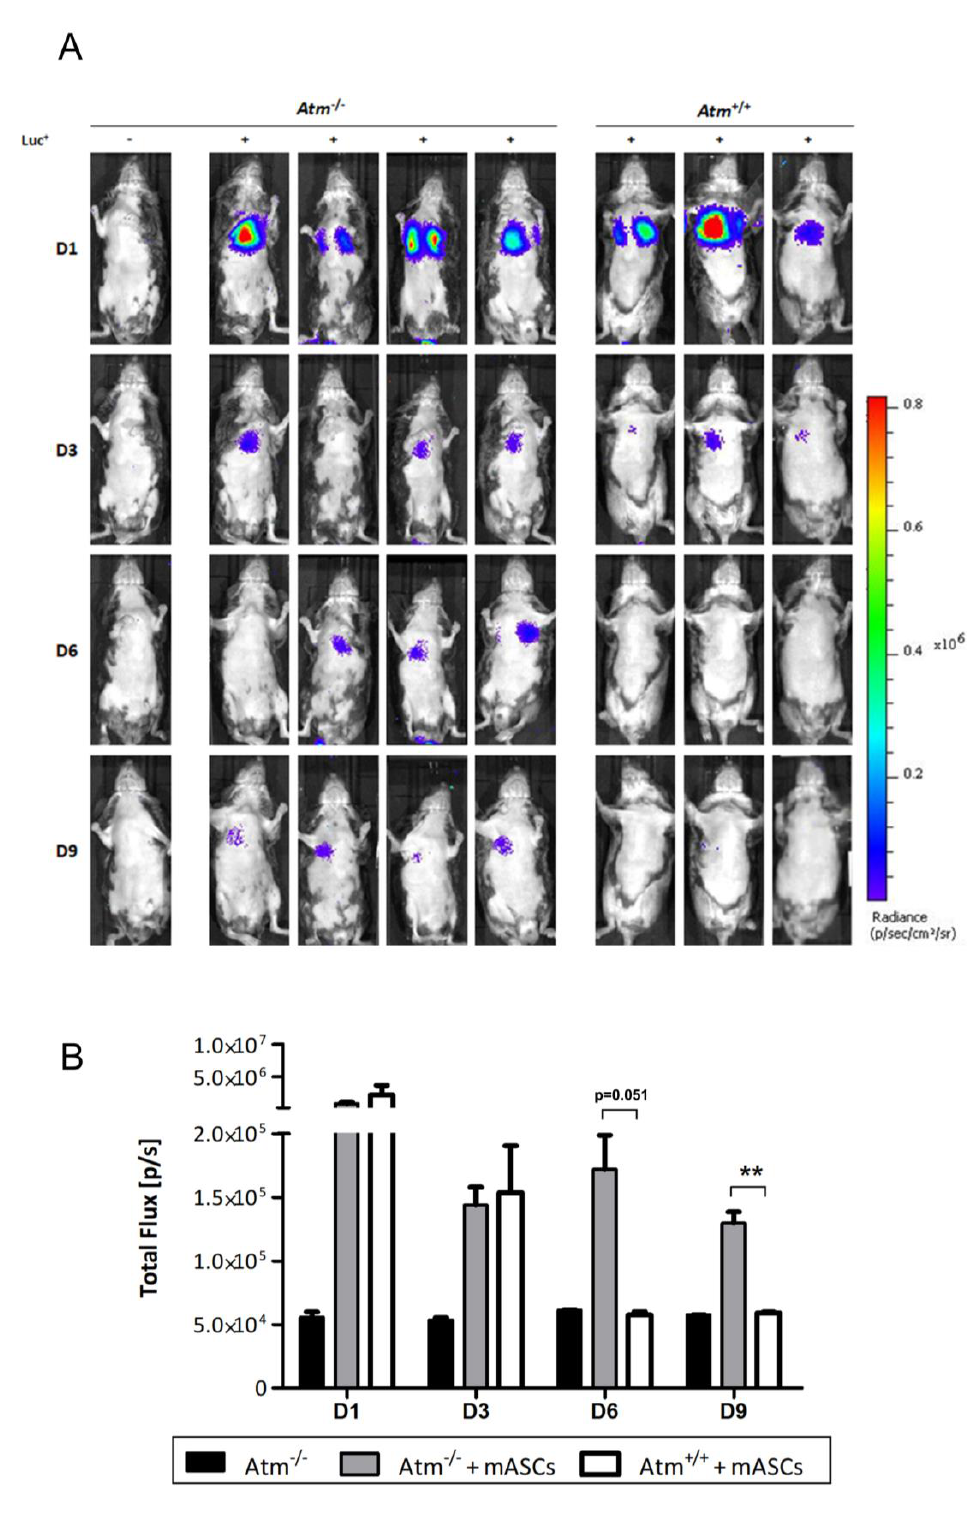
Figure 2. Retention of adipose-derived mesenchymal stromal/stem cells (ASCs) isolated from luciferase transgenic mice (mASCs) into the lung tissue of Atm -deficient mice. ( A ) Bioluminescence imaging of mASCs transgenic for the firefly luciferase gene (Luc + ) in the lung tissue of Atm -deficient mice ( Atm −/− , n = 4) and wild type mice ( Atm +/+ , n = 3). MSCs were analyzed at days 1, 3, 6, and 9 after transplantation. ( B ) Quantitative analysis of the light emission data of the analyzed bioluminescence signals from untransplanted Atm − / − mice (black bars, n = 3), Luc + mASCs transplanted Atm − / − mice (grey bars, n = 4), and Atm +/+ mice (white bars, n = 3). ** p <